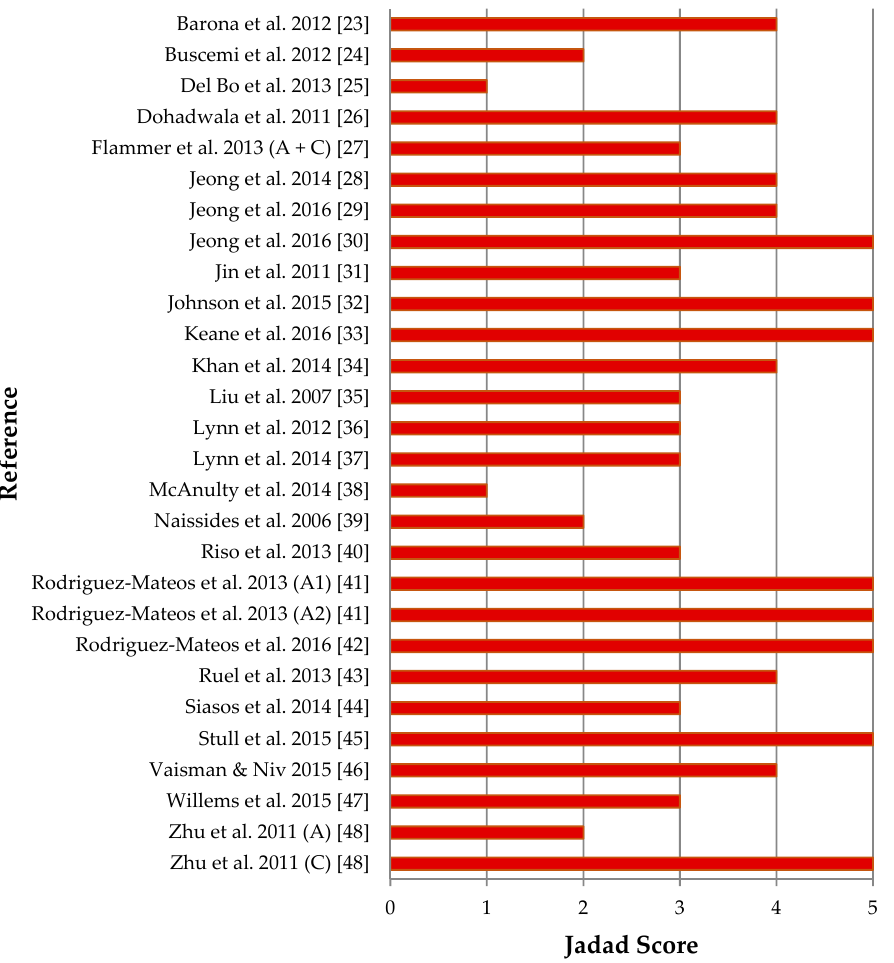
Figure 2. Jadad quality assessment of eligible studies; Abbreviations: A, Acute study; A1, Acute study 1; A2, Acute study 2; C, Chronic study.